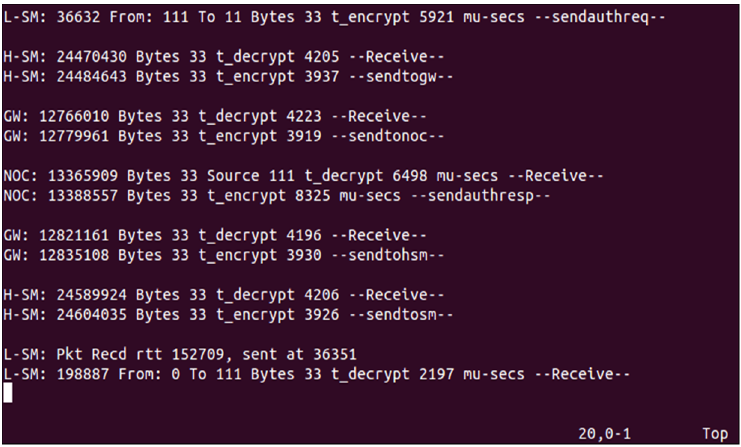
Figure 8. The output of the motes from the L-SM to NOC and back.